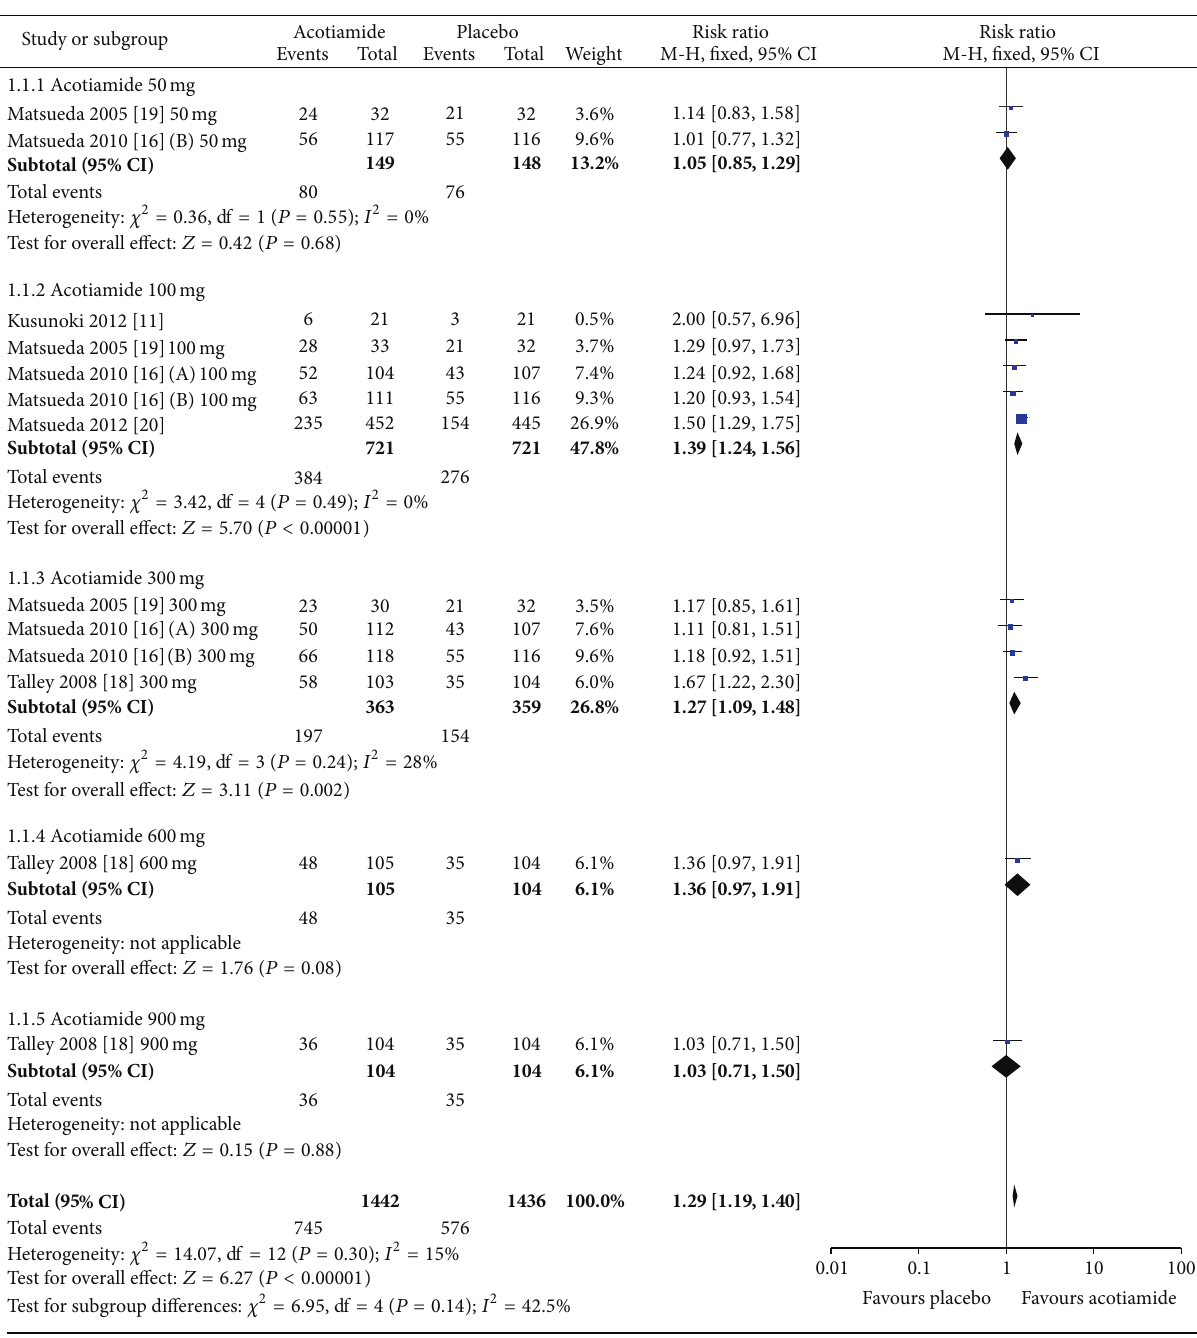
𝐼 2 = 0 %), as shown in Table 2. As to EPS, the